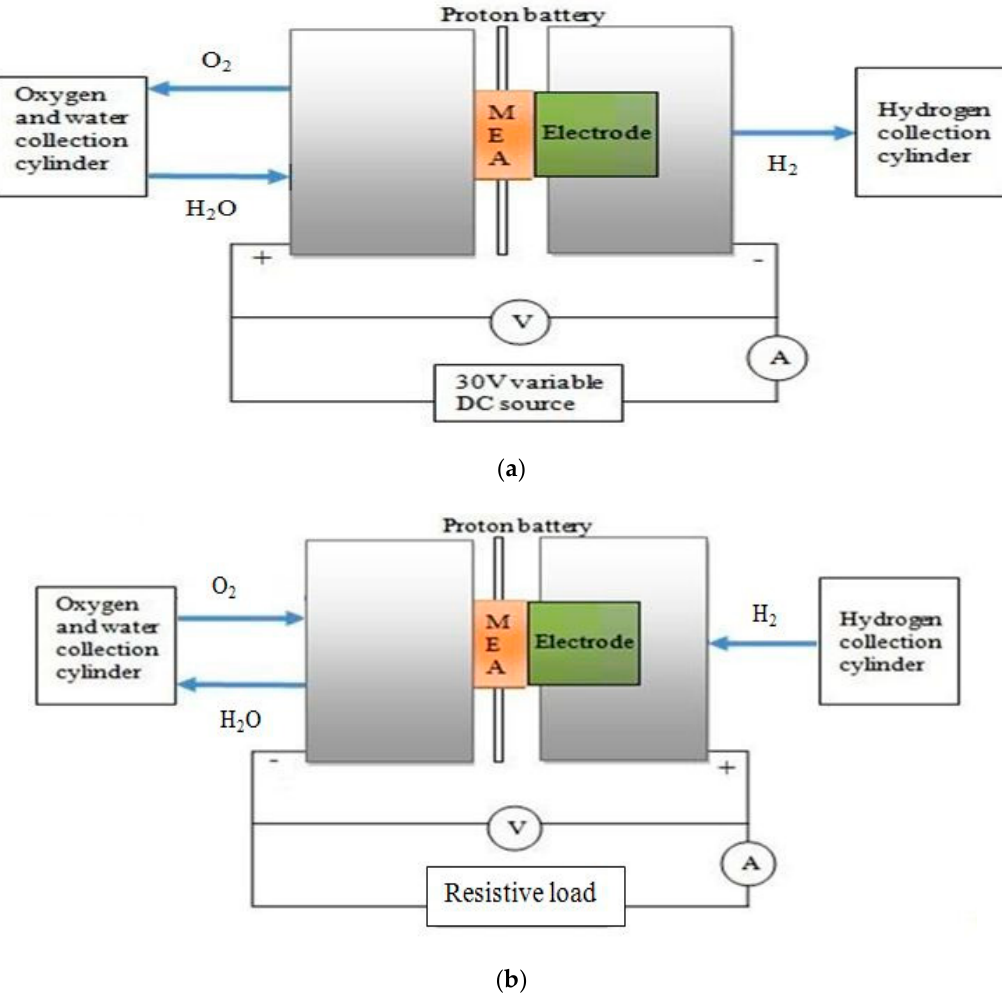
Figure 11. ( a ) Schematic diagram of charging mode of the modified unitized regenerative fuel cell (URFC) or proton battery; ( b ) schematic diagram of discharging mode of modified URFC or proton